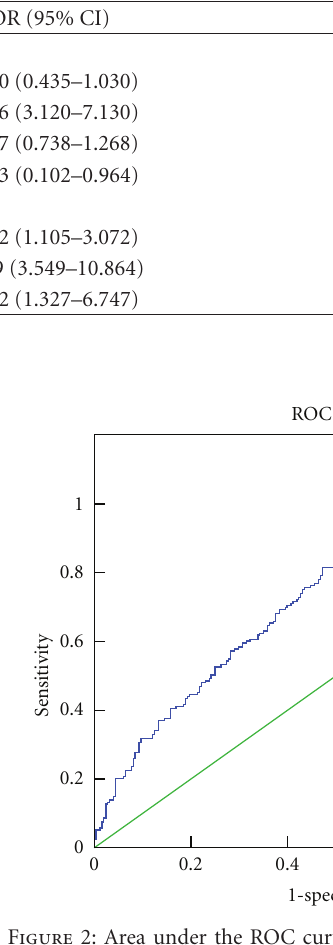
Figure 2: Area under the ROC curve for prediction of metabolic syndrome using a combination of three biomarkers viz oxLDL, hsCRP and